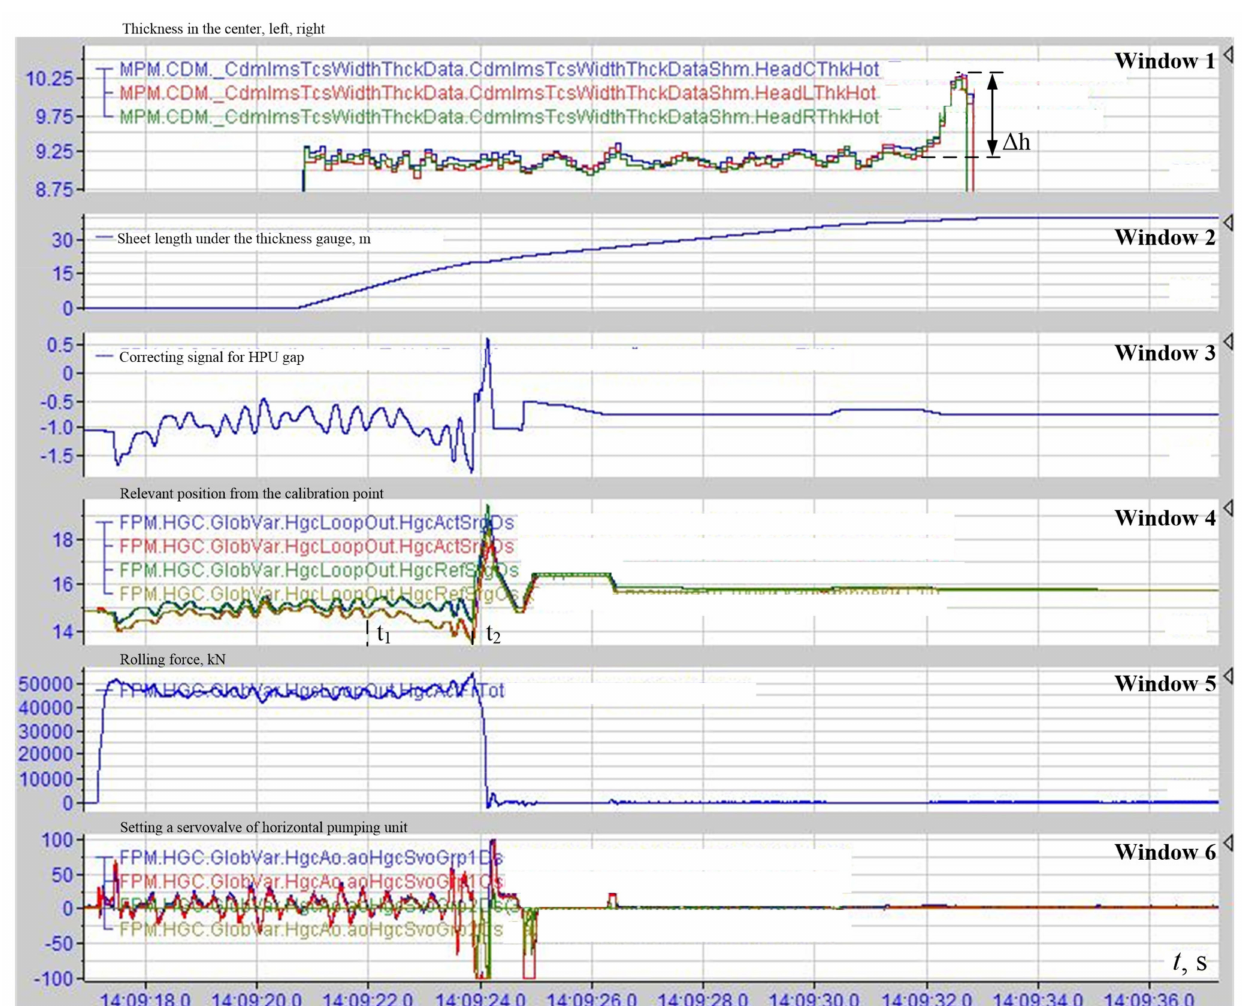
Figure 14. Oscillograph records of operation of hydraulic SDs and AGCS at the implementation of suggested